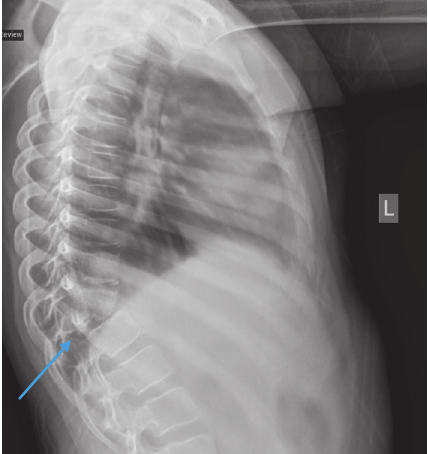
Figure 1: Lateral spine X-ray demonstrates destruction of the thoracic vertebra (T11) body and inferior end plate of the T10 vertebra with loss of disk spaces between T10, T11, and T12.